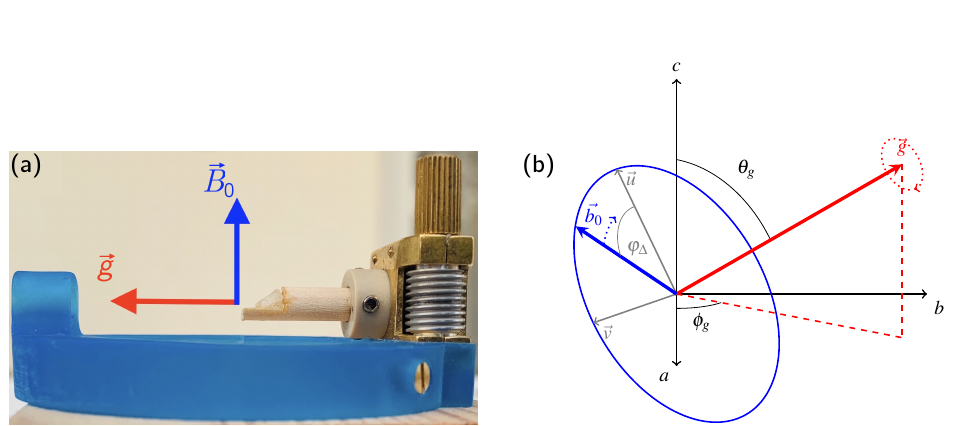
Figure 2. ( a ) ‘Clip-on’ goniometer built by NMR Service GmbH (Erfurt, Germany) for a wide-bore Bruker static NMR probe, with an arbitrary single crystal mounted on a wooden rotation axis with 5mm diameter. The goniometer axis (red) is perpendicular to the applied magnetic field (cid:126) B 0 (blue). ( b ) Co-ordinates used for the interpretation of the rotation patterns (Figure 3b,d); a , b , and c are the unit vectors of the orthorhombic crystal system ( CRY ) of anglesite, (cid:126) g is the unit vector along the goniometer axis, θ g and φ g its polar angles in the CRY , (cid:126) b 0 is the unit vector of the magnetic field, ϕ is the rotation angle, and (cid:126) u and (cid:126) v are auxiliary unit vectors necessary to define (cid:126) b 0 perpendicular to (cid:126) g [15].